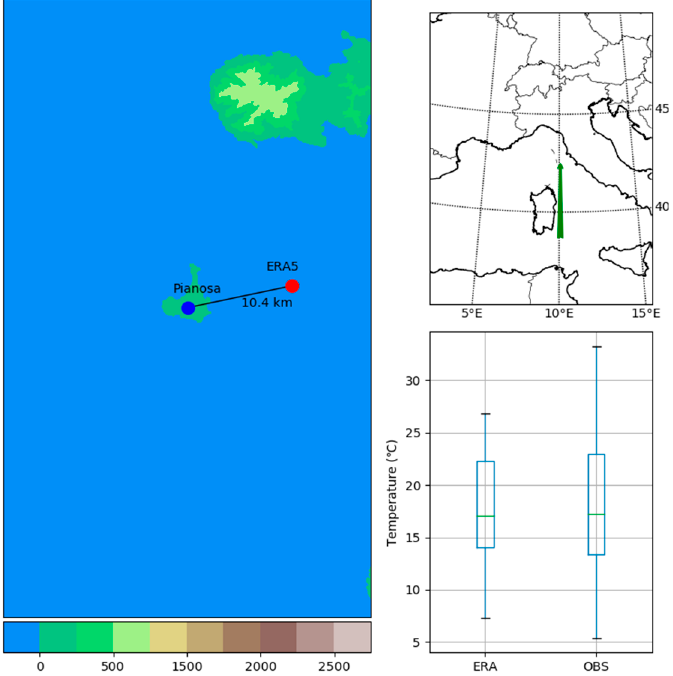
Figure 5. Altitude (m a.s.l.) and position of the Pianosa Island (Italy) automated weather station (AWS).